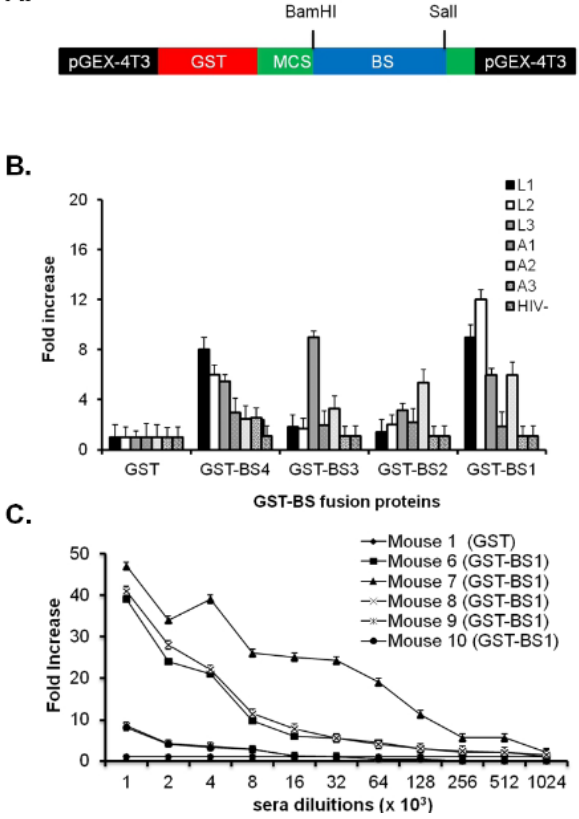
Figure 2. Antigenic and immunogenic characterization of GST-BS1 fusion protein. ( A ) Cloning strategy to link the four Bridging Sheet peptide mimotopes to the COOH-terminus of GST protein. The four Bridging Sheet peptide mimotopes (blue box) were cloned as cDNA into the Multiple Cloning Site (MCS) (green box) of pGEX-4T3 expression plasmid (black boxes) to be linked to the COOH-terminus of GST protein (red box). Bam HI and Sal I cloning sites are shown. GST-BS fusion proteins were purified as described in [62,63]. ( B ) Antigenicity of four GST-BS fusion proteins. ELISA assays were performed to analyze the reactivity of the four Bridging Sheet peptides as fusion proteins against IgGs purified from LTNP and AIDS patient sera. IgGs purified from a HIV-1 negative donor were used as a control. Results are reported as HIV + IgGs/HIV-IgGs ratio (fold increase) and a fold increase ≥3 was a positive result. The graph reports the mean of five independent experiments and the error bars. According to the Student’s t test result obtained by IgGs purified from LTNPs was statistically significant with a p < 0.05. ( C ) Mice antibody titers against GST-BS1 fusion protein. Bridging Sheet specific antibody titers were analyzed by performing a direct ELISA assay. The graph shows the results from three independent experiments and the antibody titers obtained immunizing the mouse 7 (black triangle) were statistically significant, by Student’s t test, with a p < 0.01. The data are reported as GST-BS1 immunized mice/GST immunized mouse (full black rhomb) ratio (fold increase) and sera dilutions with a fold increase ≥3 were positive. Error bars are indicated. The values of sera dilutions on the horizontal axis have to be incremented ×10 3 as